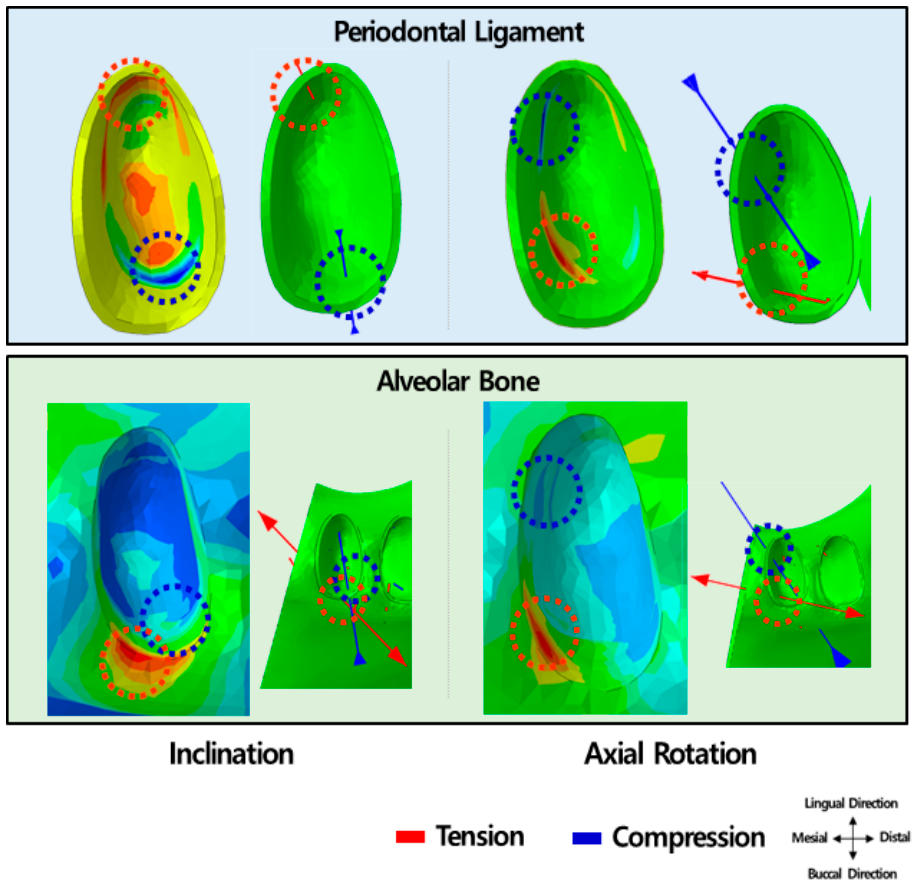
Figure 17. Distribution and direction of principal stress of the periodontal ligament and alveolar bone in orthodontic treatment using a transparent aligner. In the axial rotation treatment, the expected direction and location of the tension and compression principal stress was the same in the periodontal ligament and in the alveolar bone. In inclination treatment, compression was predicted to be in the buccal direction at the middle point between the periodontal ligament and the alveolar bone. In contrast, tension was predicted to be present in the lingual-cervical part of the periodontal ligament and buccal-cervical part of the alveolar bone. Based on pressure-tension theory, in such cases, new bone formation and bone resorption in axial rotation treatment using transparent aligner would proceed without difficulty, as the tension and compression principal stress are in the same direction. However, in inclination treatment, the location of tension principal stress differed, suggesting that new bone formation would be slower than bone resorption.